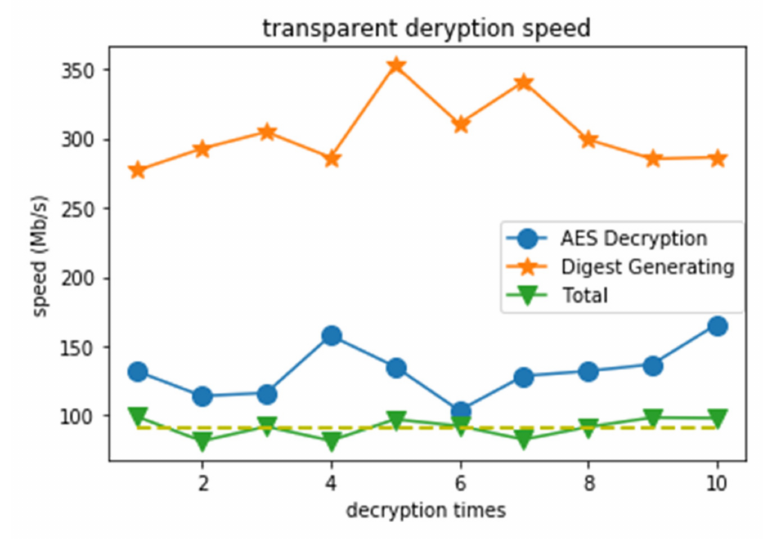
Figure 5. Speed of transparent decryption.